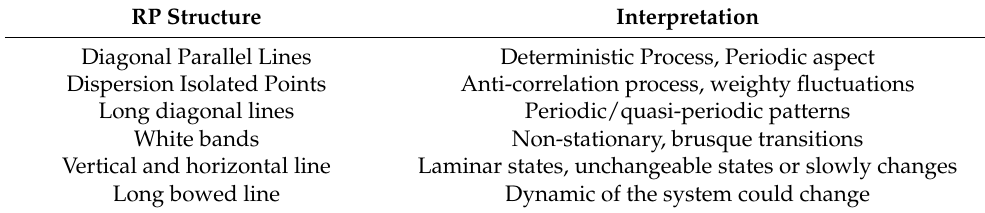
Figure 3. Phase spaces and RPs of normal glottal signal and pathological glottal signal. Table 2. Interpretation of recurrent plot structures.